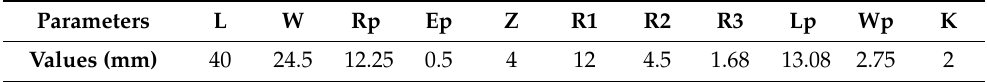
Figure 1. The proposed antenna structure ( a ) Top view ( b ) Back view. Table 1. Size specifications for the proposed antenna.